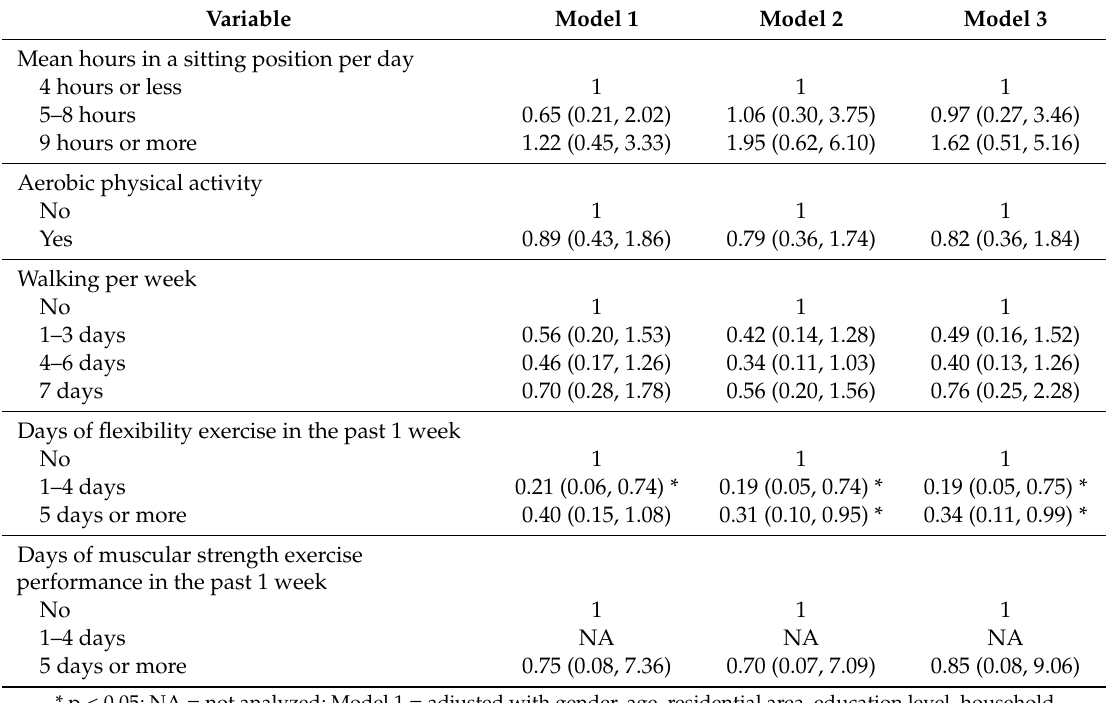
Table 3. Relationship between a physical activity and depression: complex sample logistic regression model, pOR (95%